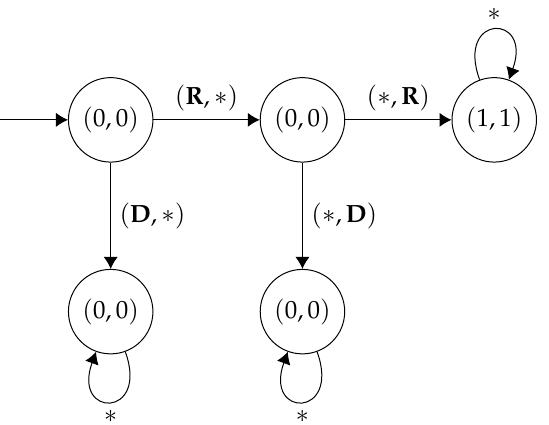
Figure 5. NE ( G 1 ) (cid:42) CORE ( G 1 ) . The asterisks * are wildcards—they match any action which isn’t explicitly detailed on the